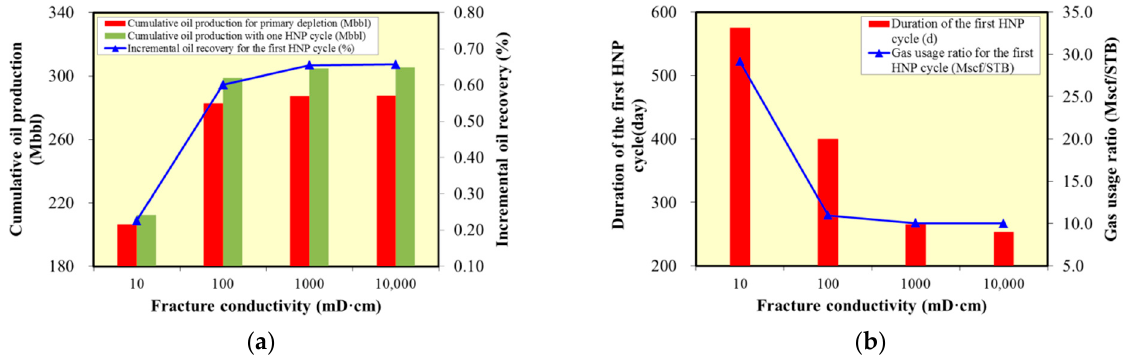
Figure 20. Correlation between fracture conductivity and huff-n-puff results: ( a ) Cumulative oil production and incremental oil recovery for different fracture conductivity; ( b ) Duration of the first huff-n-puff cycle and gas usage ratio for different fracture conductivity.